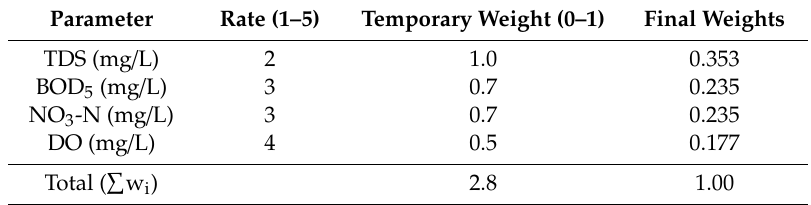
Table 4. The developed weight factor for each water quality parameter in the IWQI.